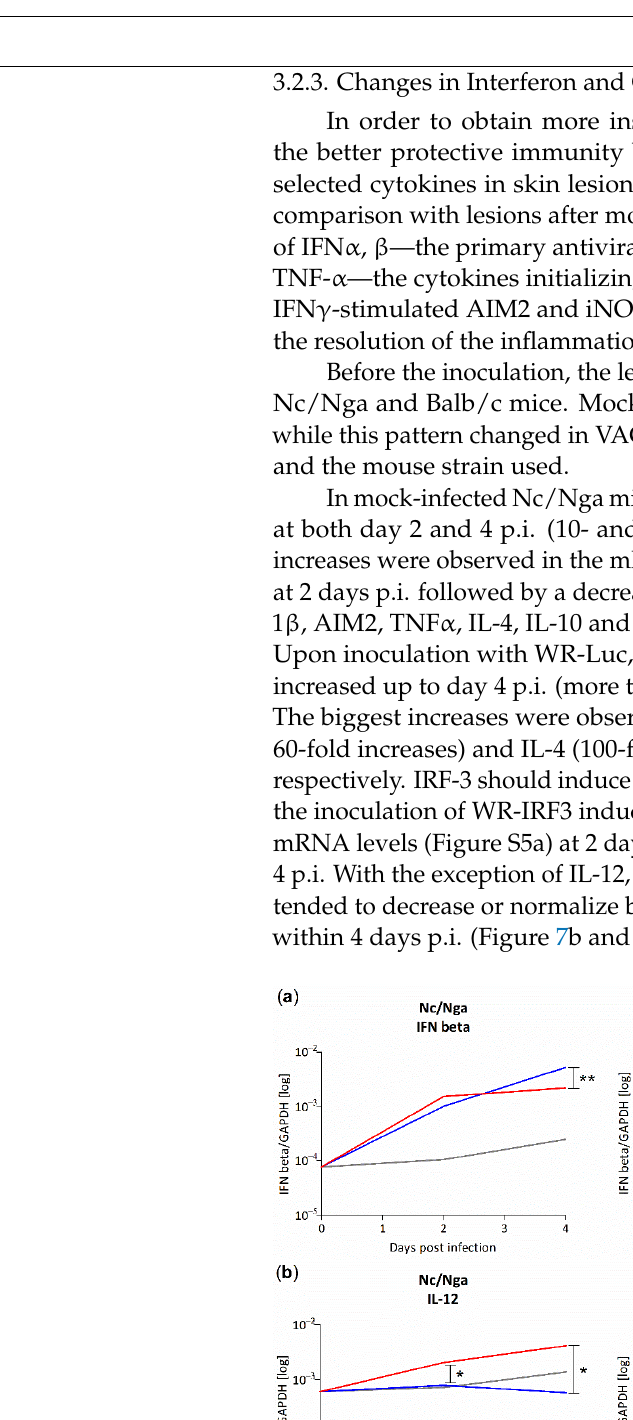
Figure 6. Immunization with WR-IRF3 induces better protective immunity against a lethal challenge with wt-WR. Nc/Nga and Balb/c mice were immunized t.d. (10 4 PFU/mouse) or i.n. (10 3 PFU/mouse)